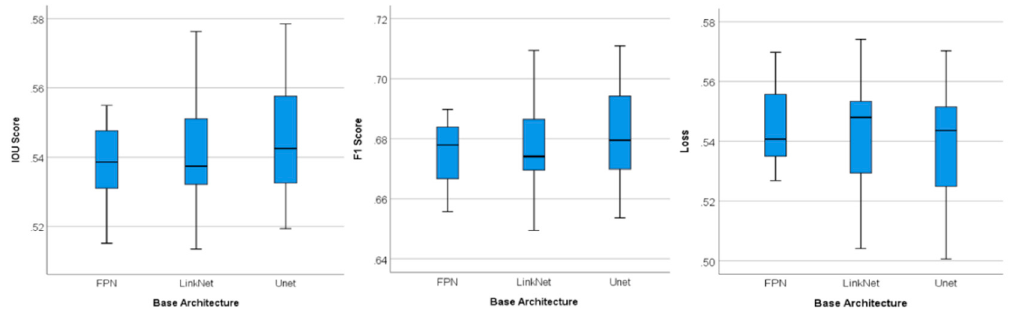
Figure 5. Boxplots of performance metrics grouped by the base architectures.